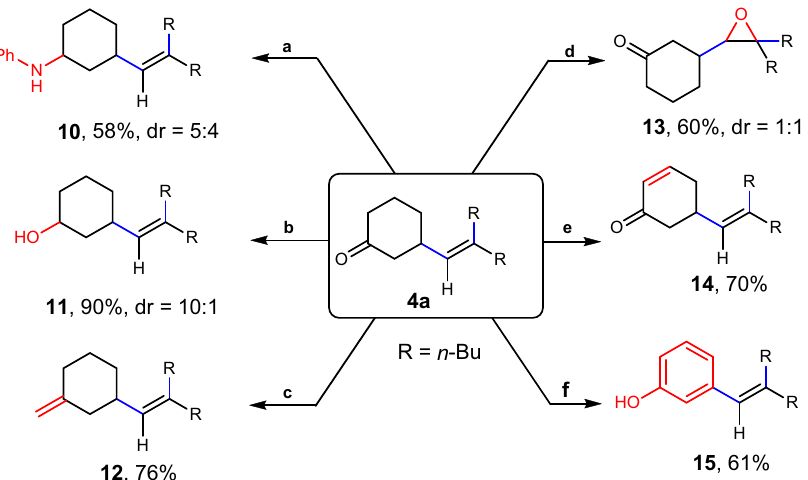
Fig. 5 Synthetic applications of 4a. Reaction conditions: a Reductive amination. (1) PhNH 2 , MgSO 4 , AcOH, DCM (0.2 M), rt, 2 h; (2) NaBH 3 CN, MeOH, rt, 10 h. b Reduction. NaBH 4 , MeOH, rt, 2 h. c Wittig Ole fi nation. n -BuLi, Ph 3 PCH 2 Br, THF, − 30 °C to rt, overnight. d Epoxidation. m -CPBA, NaHCO 3 , DCM, 0 °C, 2 h. e Desaturation. Pd(TFA) 2 , 1 atm O 2 , DMSO, 85 °C, 14 h. f Aromatization. Pd(TFA) 2 , PTSA, N,N-dimethylpyridin-2-amine, 1 atm O 2 , DMSO, 80 °C, 24